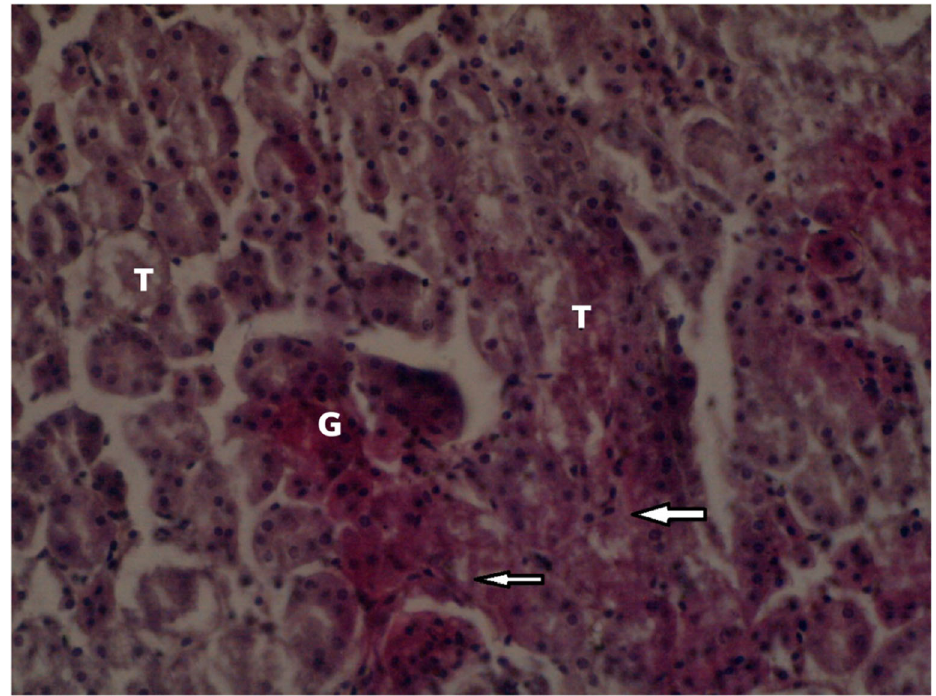
Figure 4. Localized tubular epithelium necrosis in the low dose group ( (cid:1) 400). No adjustments were made in terms of contrast or